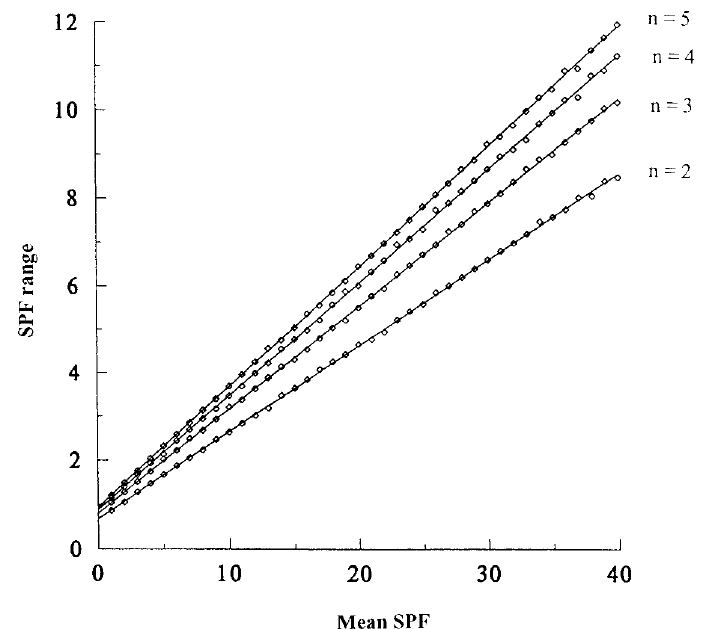
Fig. 1. The statistically calculated 95th percentile curves for linear relationship between the SPF range and mean SPF for each tumor with 2, 3, 4 or 5